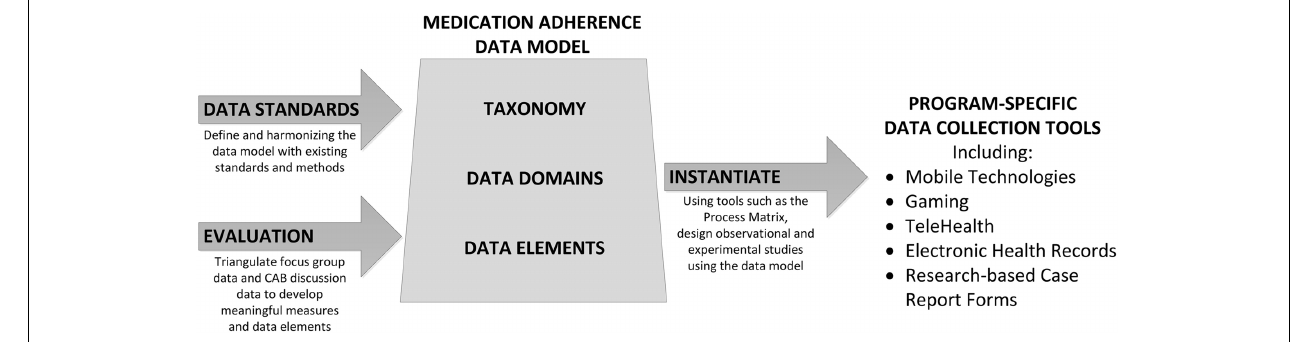
FIGURE 2 | Proposed data model.